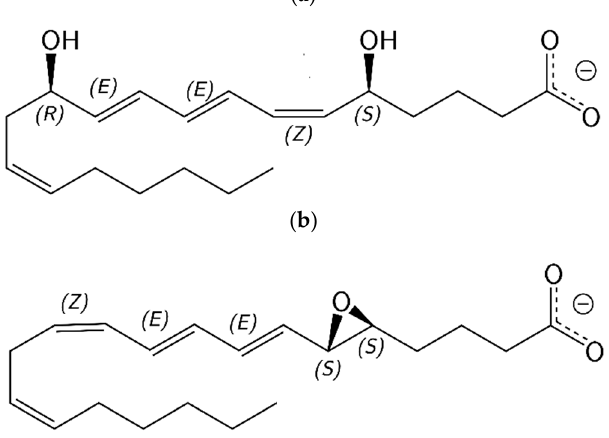
Figure 1. Structures corresponding to LTB 4 ( a ) and LTA 4 ( b ).